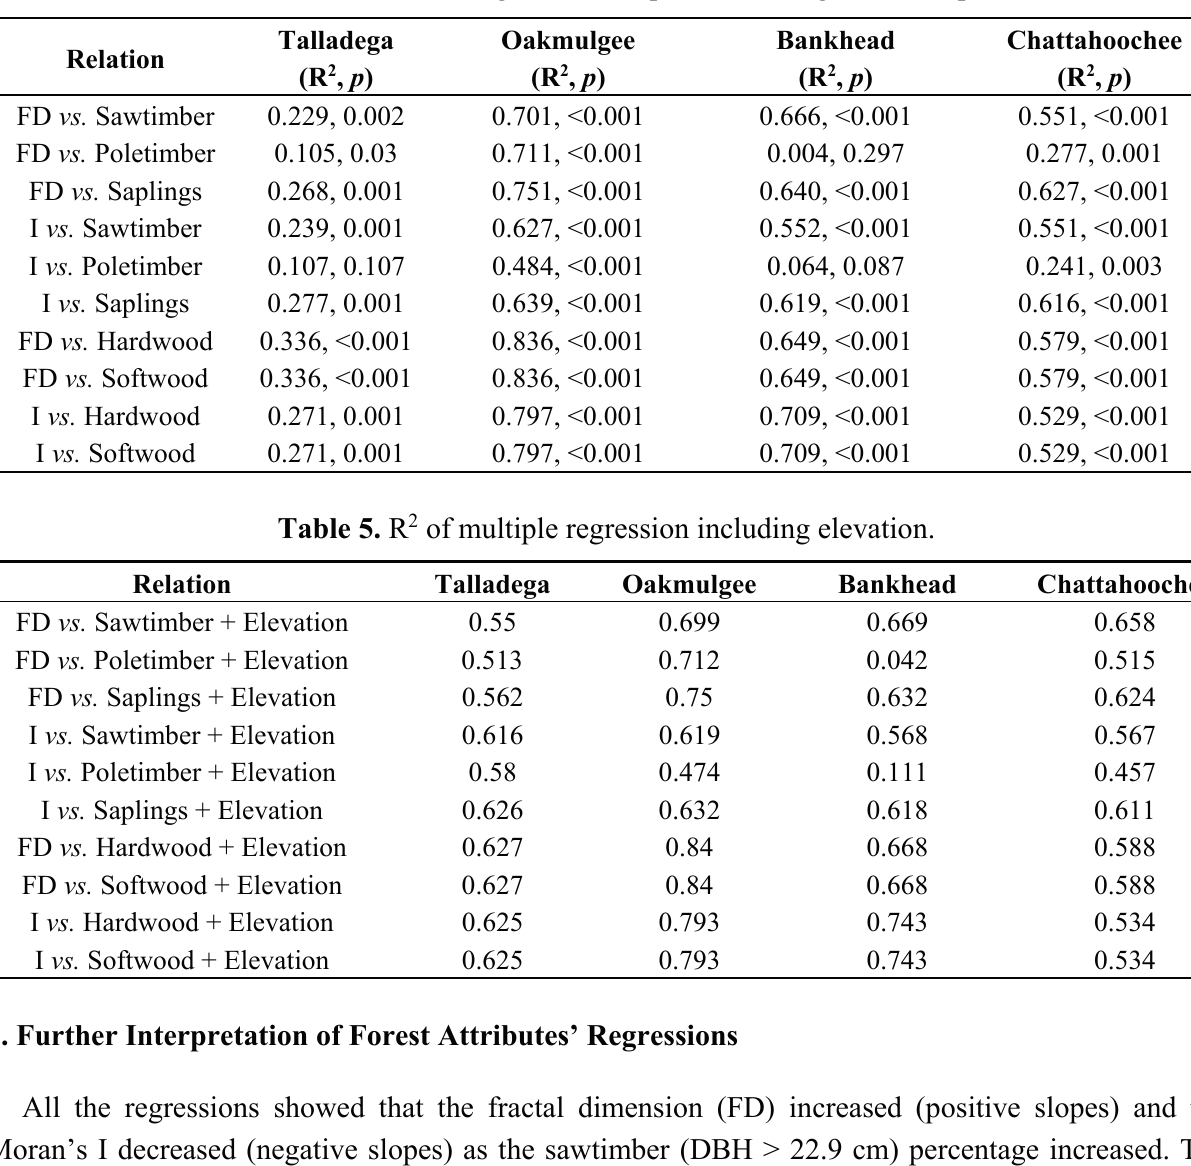
Table 4. R 2 values of regression and p values of regression slopes.